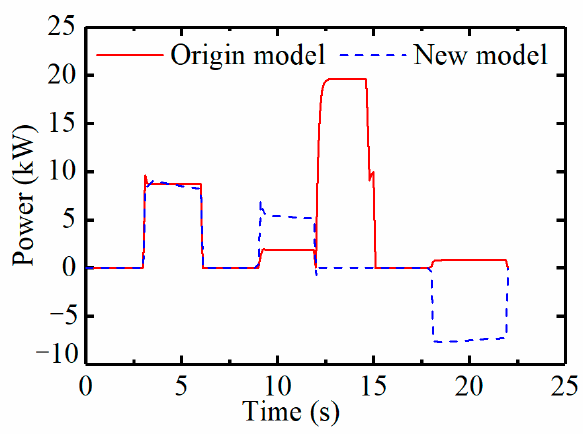
Figure 11. Power curve of the VPM.